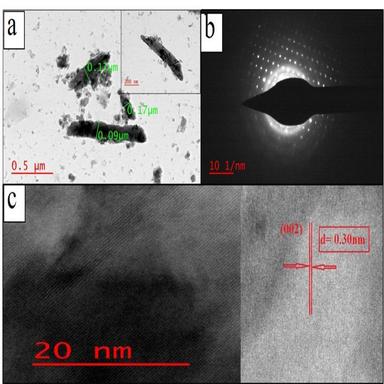
(a) TEM micrograph (b) SAED pattern and (c) HRTEM micrograph of as- synthesized ZnSe NRs.